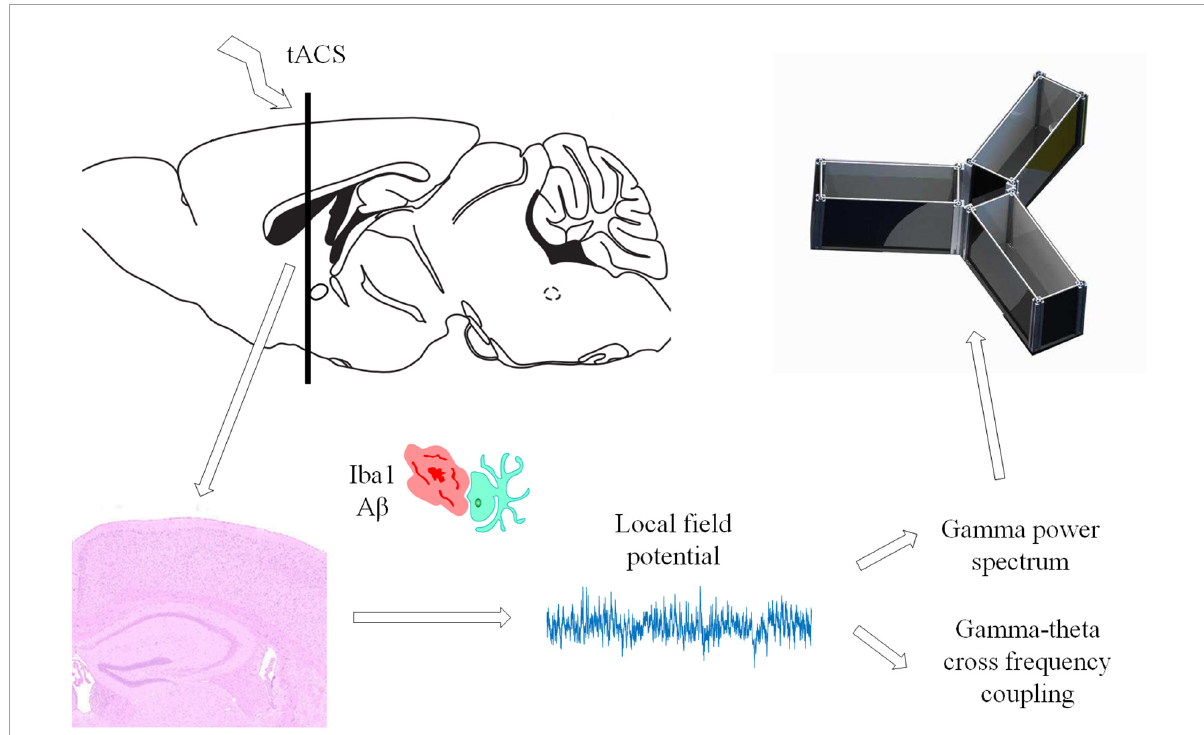
FIGURE9 Summary diagram showing that long-term tACS improves the memory function of AD